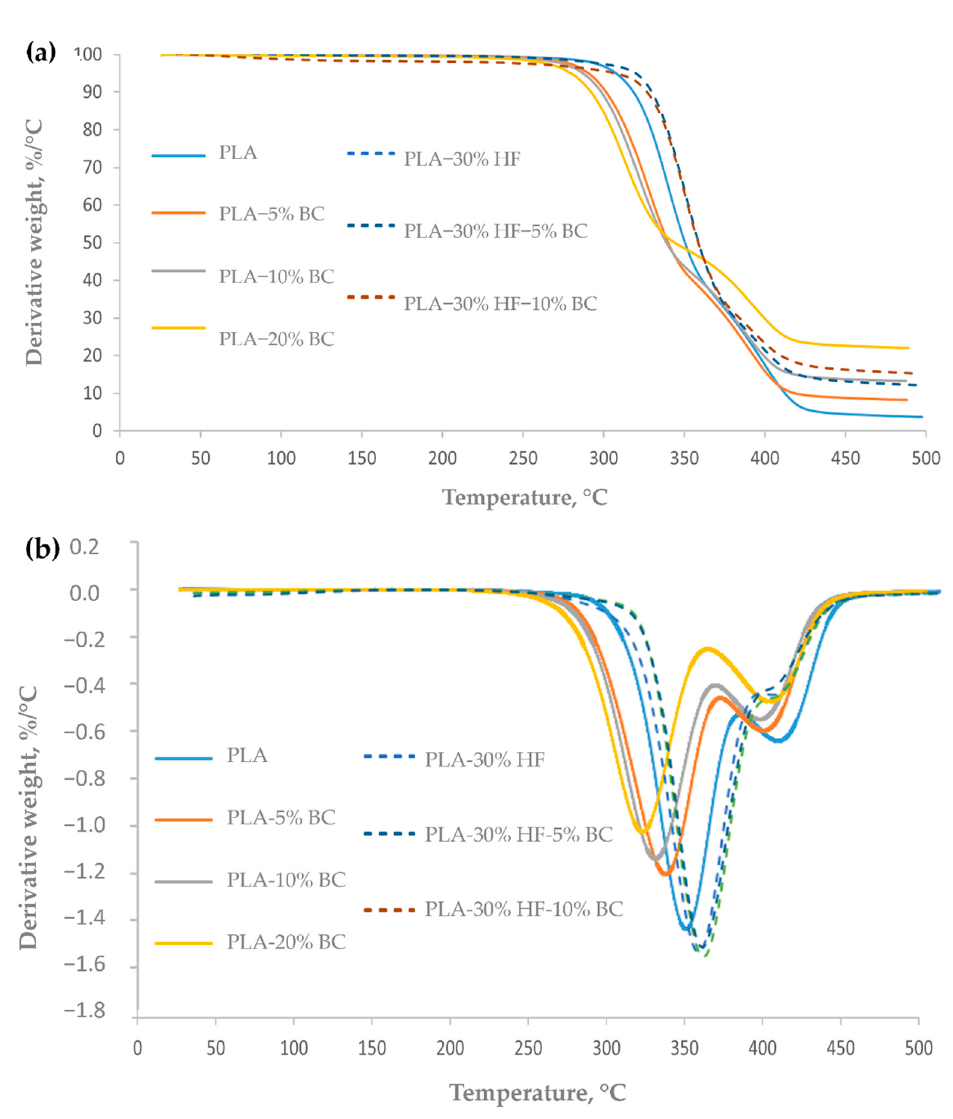
Figure 3. TG ( a ) and dTG ( b ) thermograms of PLA-based composites. Table 5. TGA analysis results of PLA-based composites.